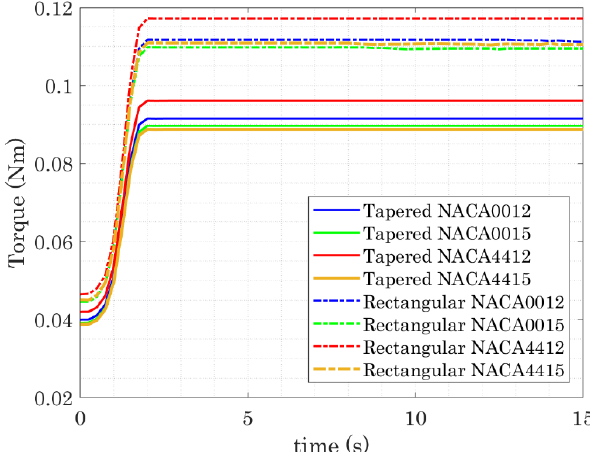
Figure 7. Steady-state torque. Table 7. Power generation for the studied blade shapes and corresponding airfoil profiles. Blade Shape